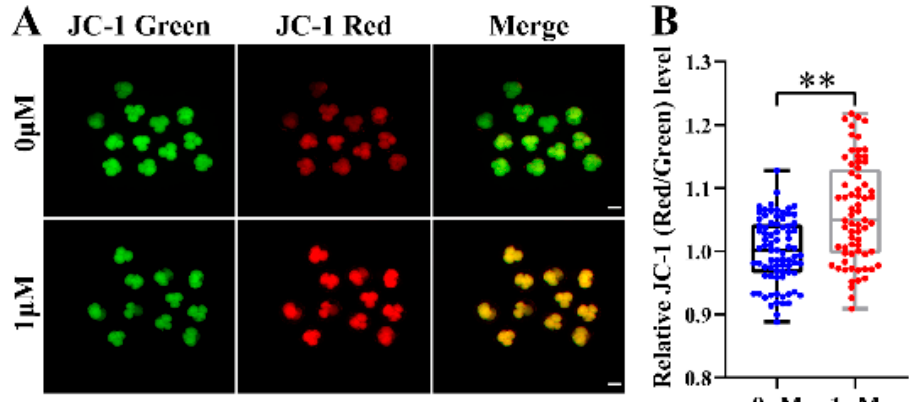
Figure 5. Effect of chrysoeriol (CHE) on the mitochondrial membrane potential (MMP). ( A ) Representative image of JC-1 staining at the 4-cell stage of porcine embryos. Scale bar = 100 µm. ( B ) Relative JC-1 red/green levels in the control (n = 79) and the CHE treatment (n = 68). R = 4. Data represent medians and maxima and minima. Significant differences are shown as ** ( p < 0.01).